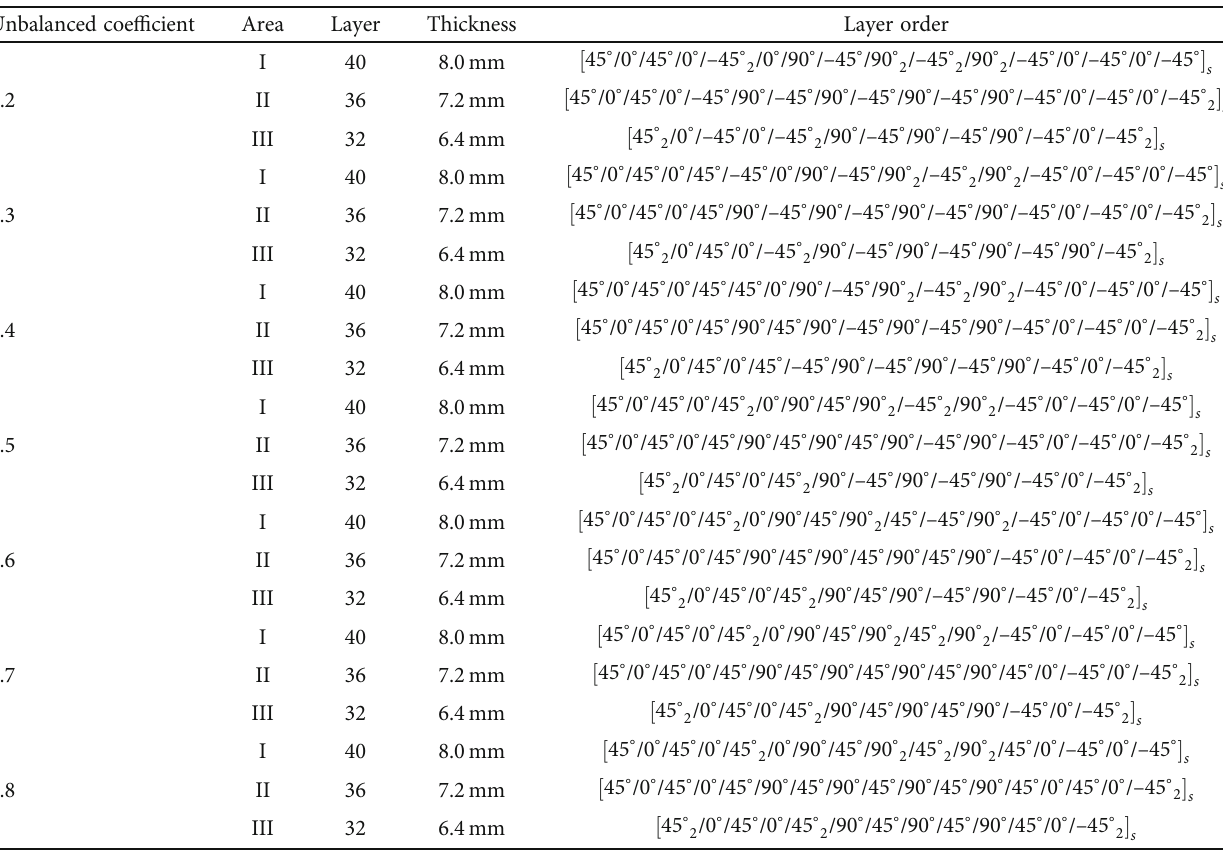
Table 5: Variable thickness and angle layup